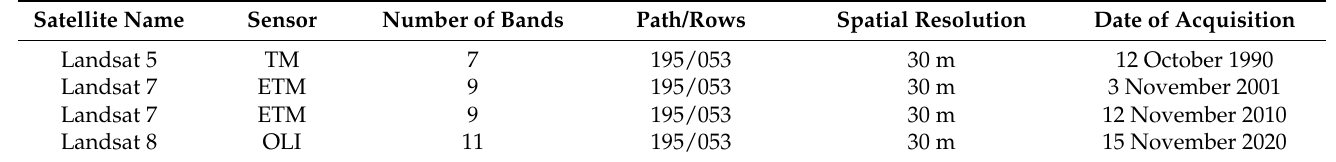
Table 1. Characteristics of data used for image classification and their date of acquisition.